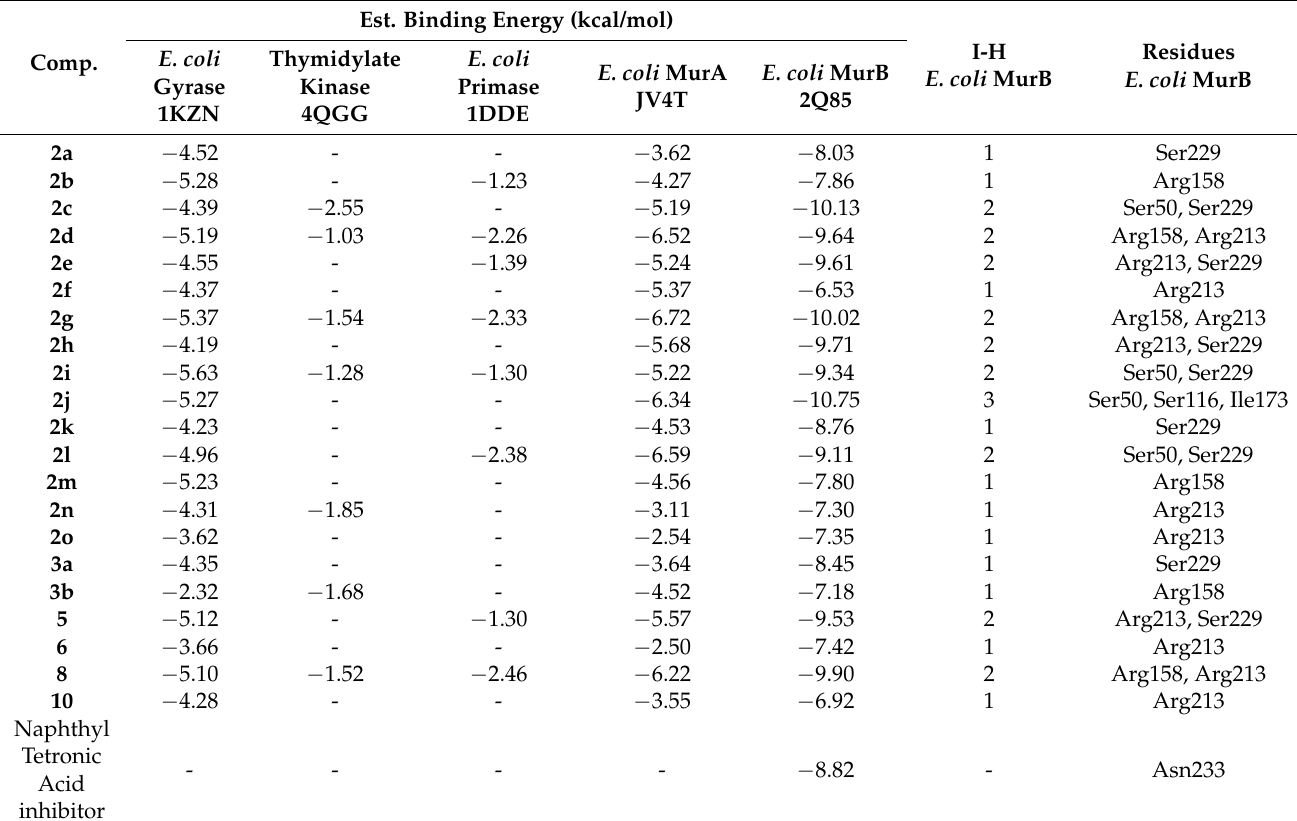
Table 3. Molecular docking free binding energies (kcal/mol) to antibacterial targets.